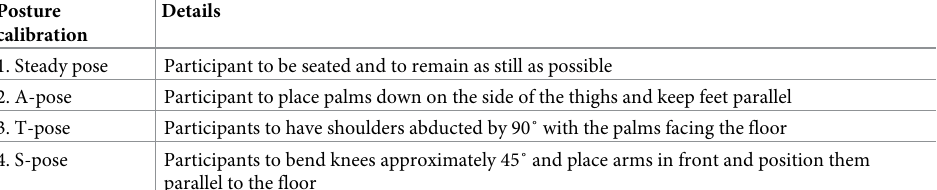
Table 1. Perception Neuron 4-step